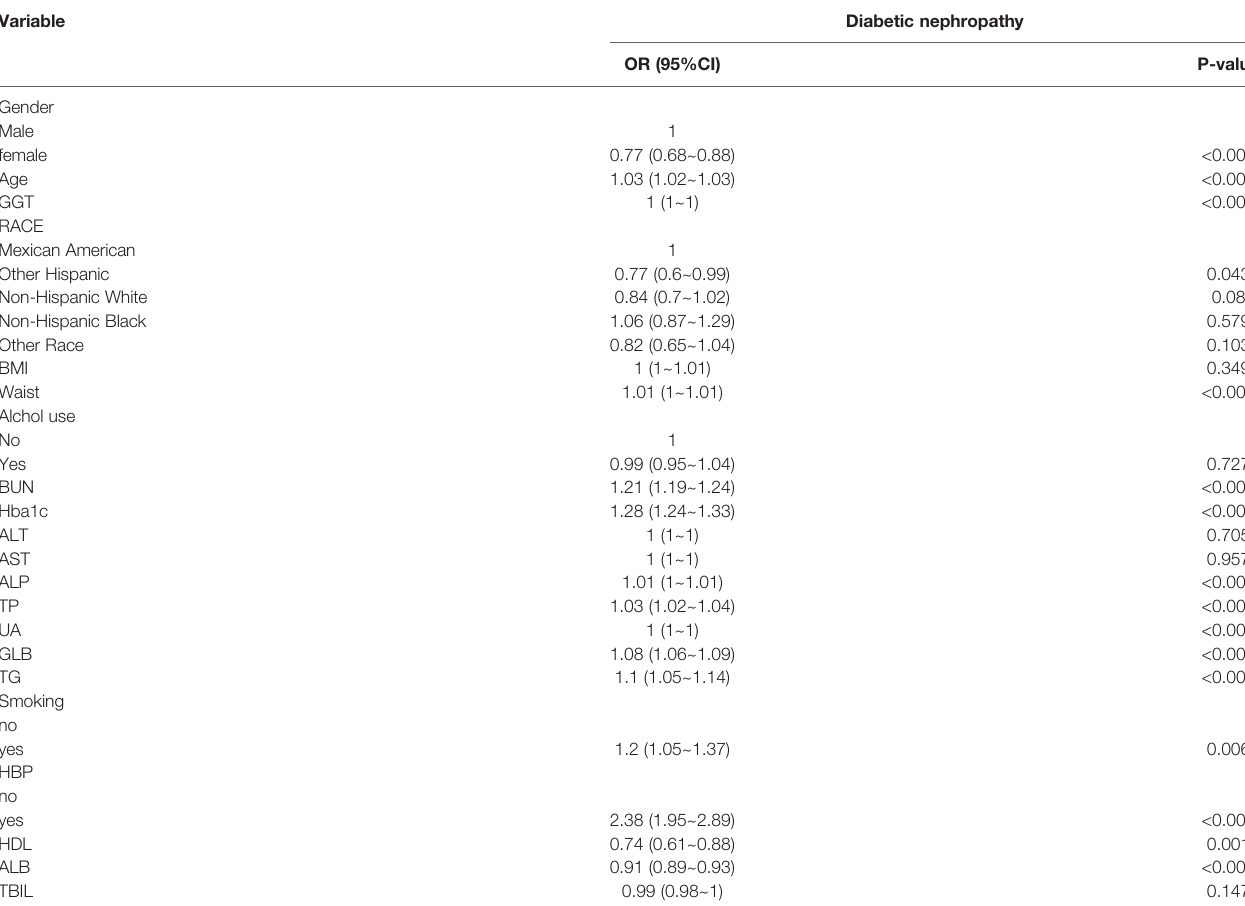
TABLE 2 | Univariate analysis of association between factors of T2DM and diabetic nephropathy. Variable